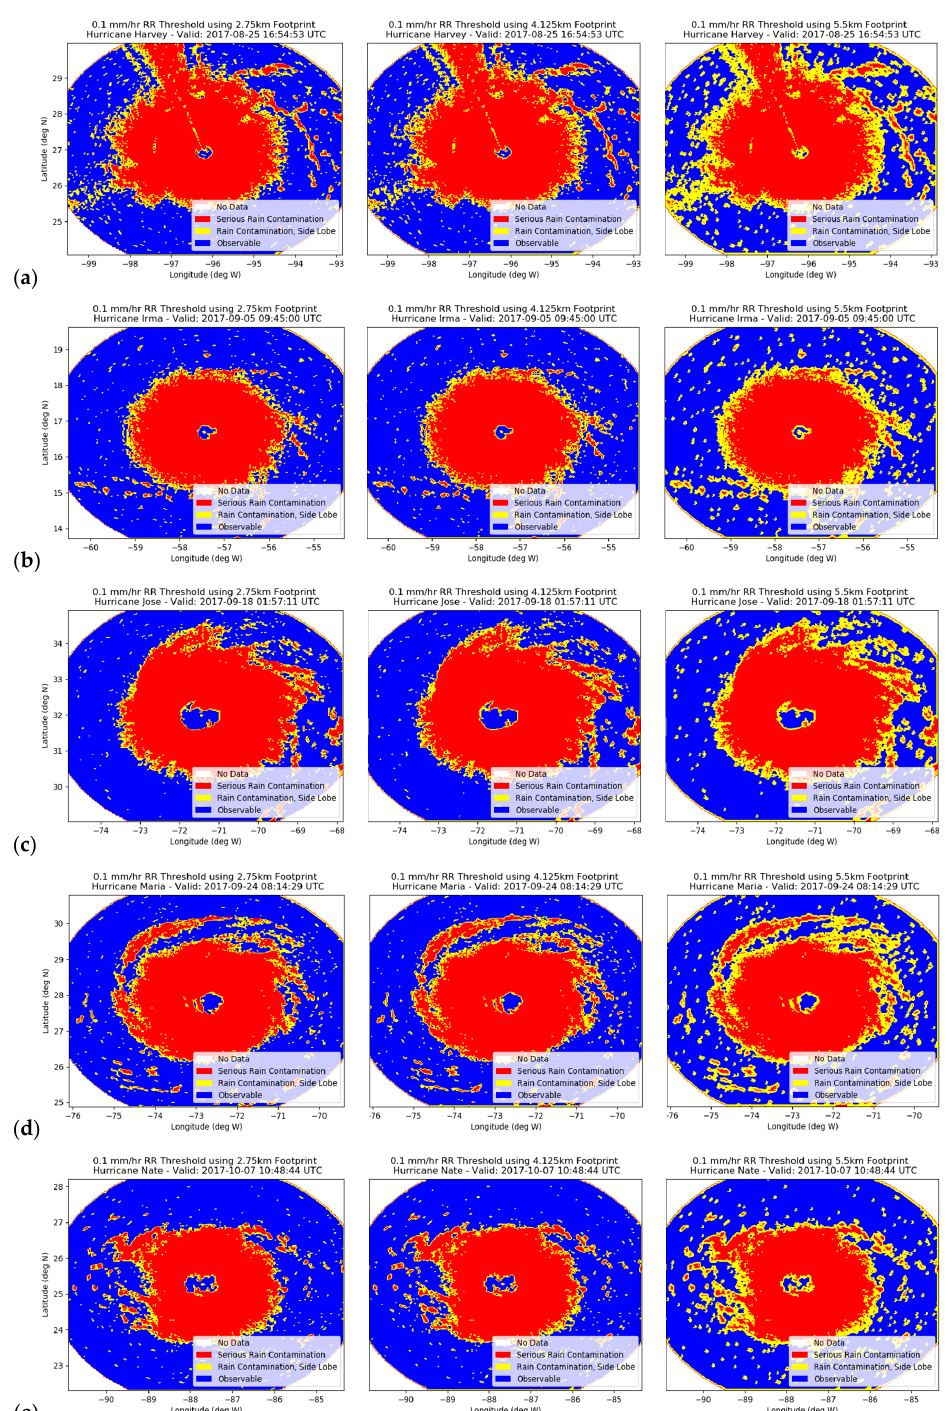
Figure 5. 0.1 mm/hr rain rate threshold applied to data for ( a ) Harvey-AL092017, ( b ) Irma-AL112017, ( c ) Jose-AL122017, ( d ) Maria-AL152017, and ( e ) Nate-AL162017. Rain rates at or below the threshold and surface observable ( blue ), rain rate at or below the threshold but surface not observable due to problems somewhere in the footprint ( yellow ), and rain rate exceeds the threshold ( red ).